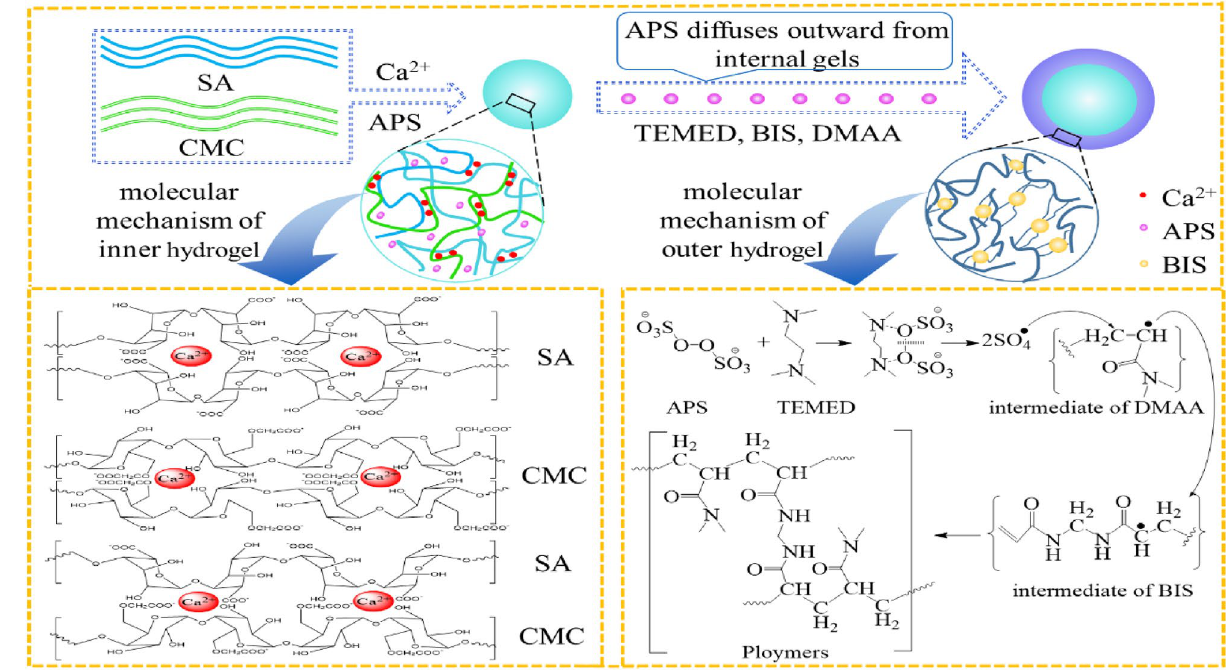
Figure 3. Formation mechanism of the double-layer